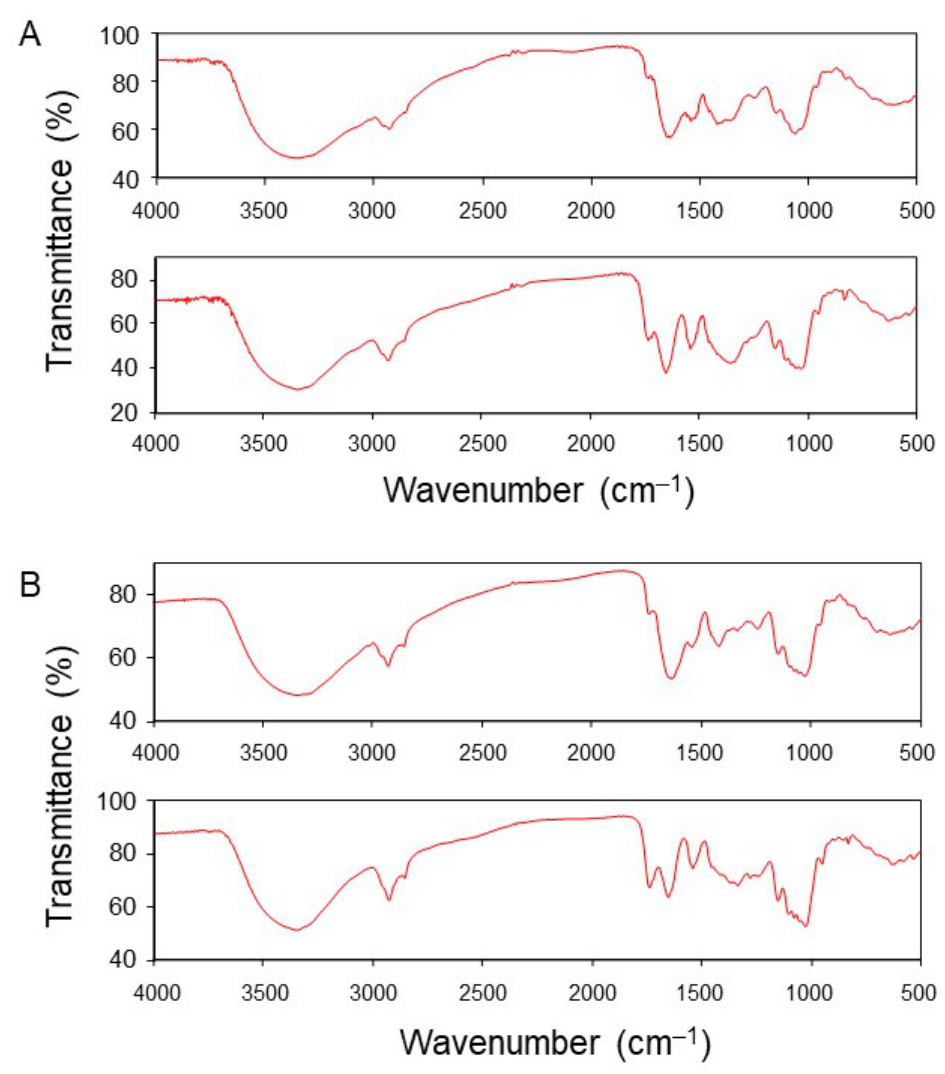
Figure 5. FT-IR spectra of the algal cells treated with and without the Pb solution. Cells of NIES-217 ( A ) and NIES-303 ( B ) were compressed in KBr plates before (upper spectra) and after (lower spectra) suspension of cells in the Pb solution.